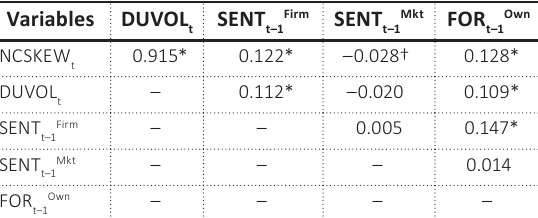
Table 3. Correlation analysis results for the